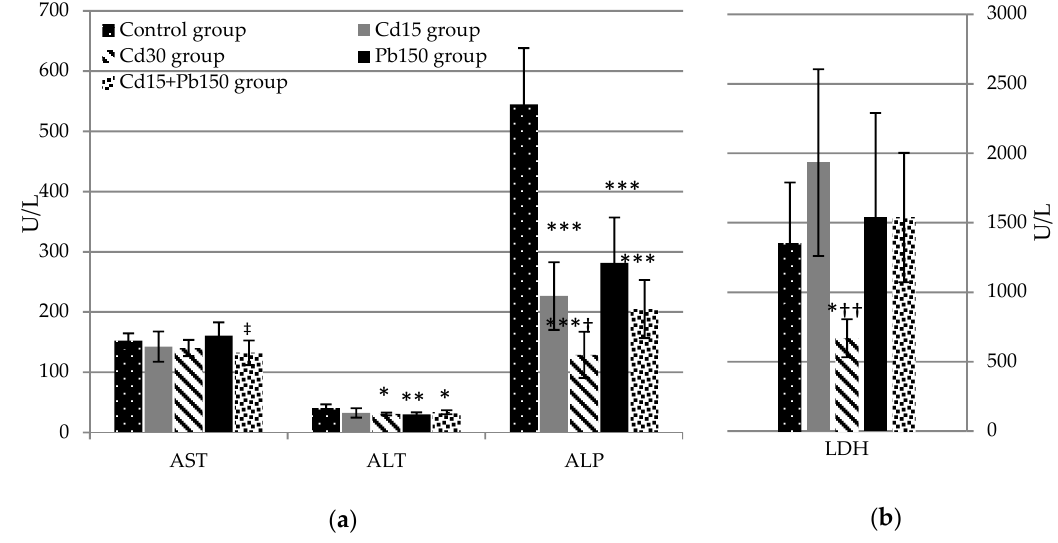
Figure 3. Effect of Cd or/and Pb on serum enzyme activities in rats after acute exposure. Aspartate aminotransferase (AST), alanine aminotransferase (ALT), and alkaline phosphatase (ALP) are represented on panel ( a ), while lactate dehydrogenase (LDH) on panel ( b ). Parameters that were not influenced by Cd and Pb treatment are not listed. Values are presented as means and S.D. Statistically significant differences ( p < 0.05) compared to control group are indicated by *, † Cd 15 group, ‡ Pb 150 group. Statistical evaluation was performed using one-way ANOVA followed by LSD post-hoc test for pairwise comparison. * † ‡ p < 0.05; ** †† ‡‡ p < 0.01; *** ††† ‡‡‡ p < 0.001.